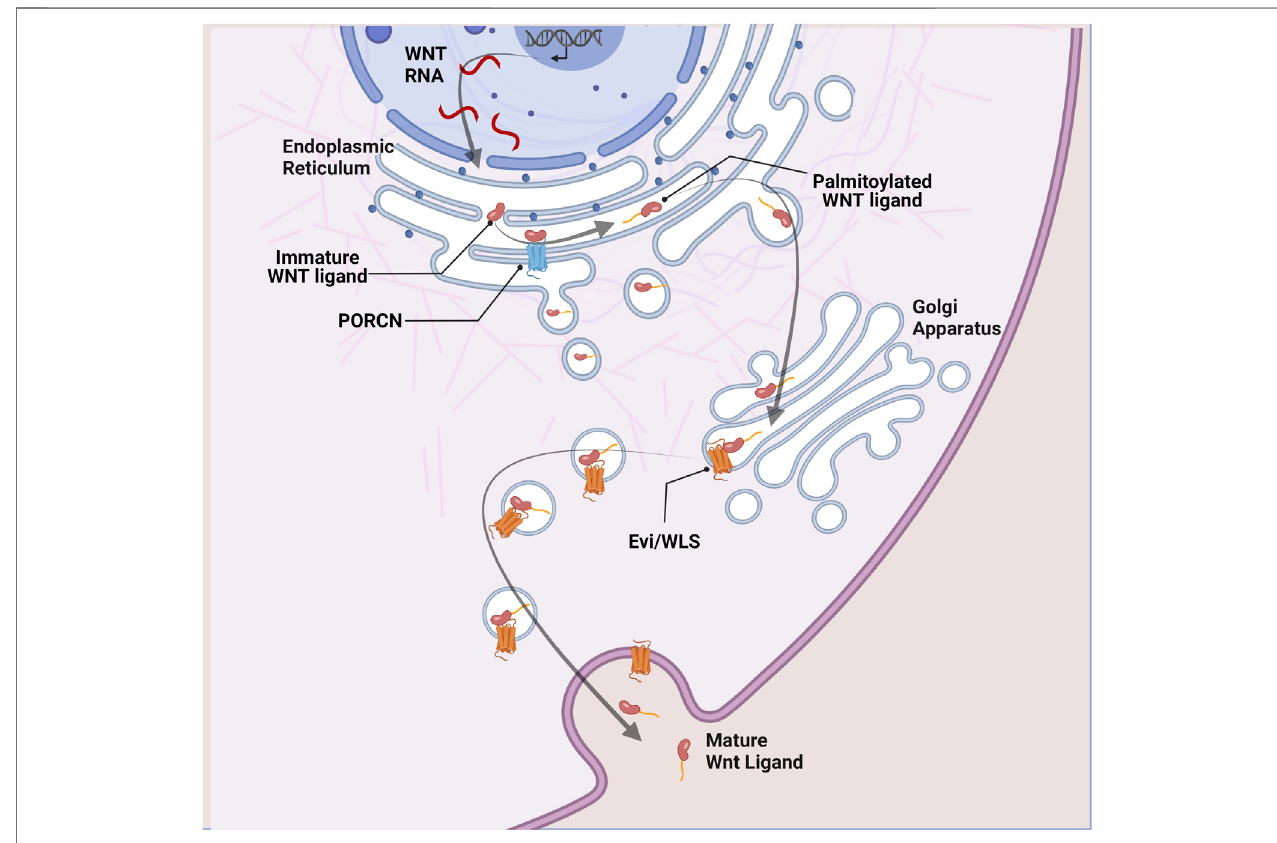
FIGURE 1 | Wnt ligand secretion. In Wnt secreting cells, immature Wnt proteins are palmitoylated in the endoplasmic reticulum by the porcupine acyl transferase (PORCN).ThisisanessentialstepintheWntsecretorypathway.Lipid-modi fi edWntligandsarethentransportedinsecretoryvesiclestotheplasmamembrane withthe help of the transmembrane protein